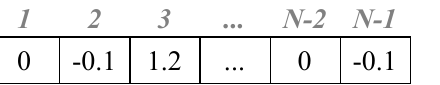
Figure 6. Codification to locate ESSs in distribution